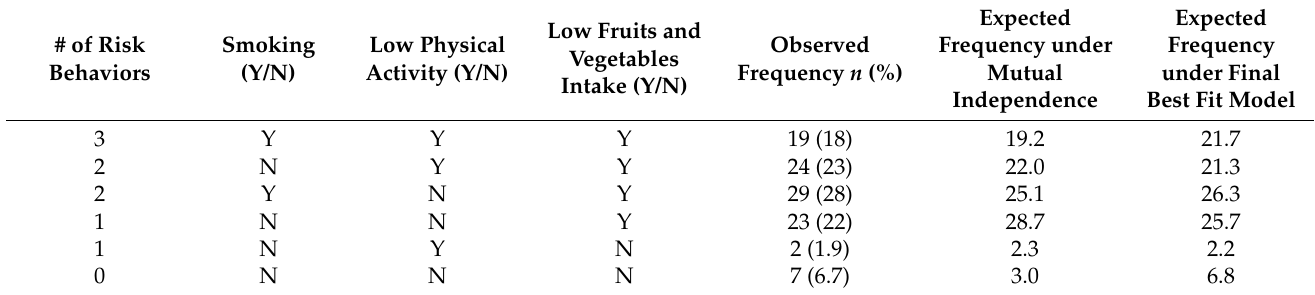
Table 4. Clustering of health behaviors among Puerto Rican men ( n = 104).